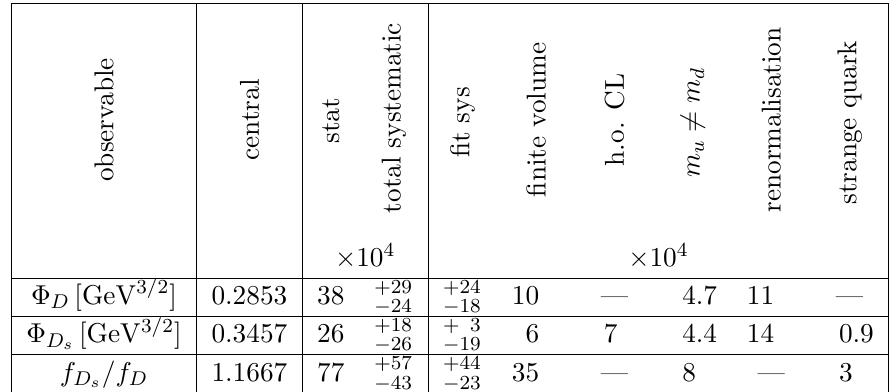
Table 9 . Summary of the systematic error budget for the quantities (cid:8) D , (cid:8) D decay constants. Details of the discussion leading to these results can be found in the